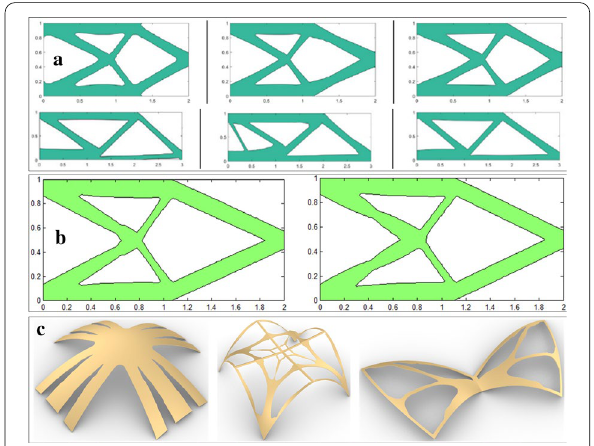
Figure 8 Some numerical results of the MMC/V-based ITO